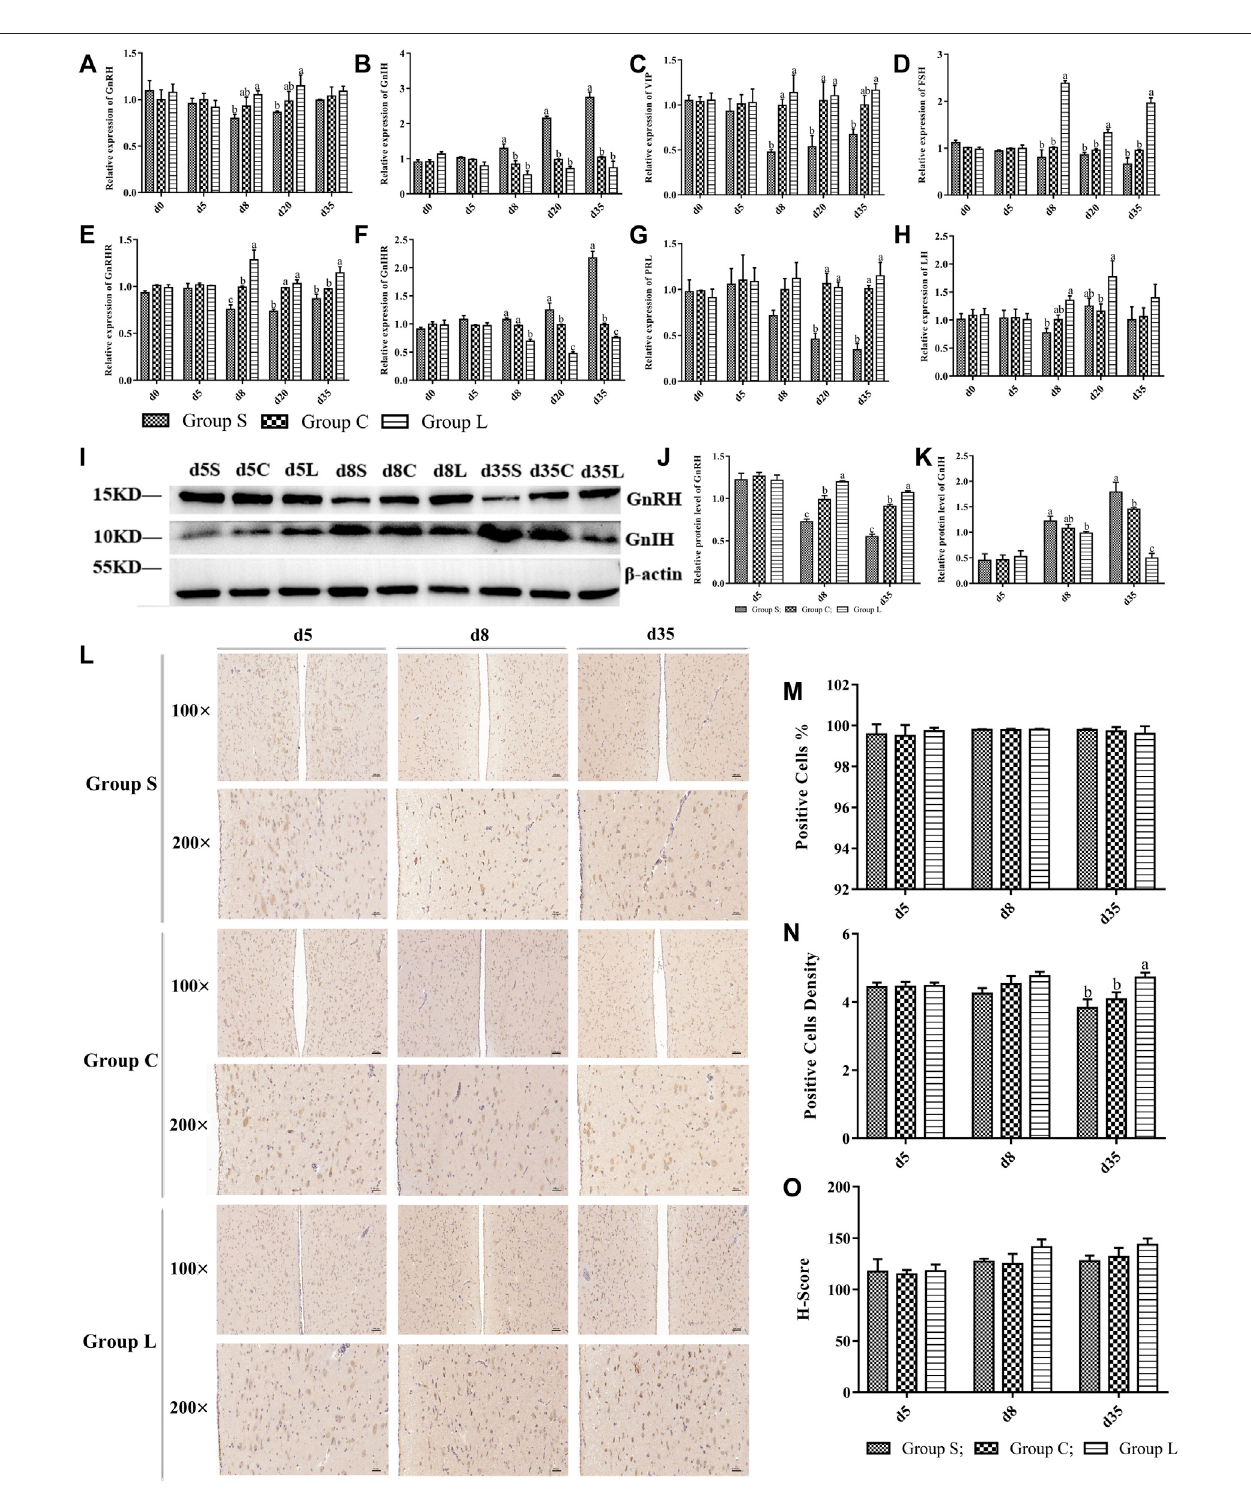
FIGURE 6 | Expression levels of main factors of HPG axis in mountain ducks under different photoperiods. Expression of HPG axis-related genes and proteins. (A – H) indicated the expression levels of the genes of GnRH 、 GnIH 、 VIP 、 FSH 、 GnRHR 、 GnIHR 、 PRL and LH, respectively; (I) , Western Blot results of relative proteinlevelsofGnRHandGnIH; (J) and (K) ,changesintheproteinexpressionofGnRHandGnIH; (L) ,theimmunohistochemicalstainingimagesofGnRH; (M – O) were quantitative analyses of the immunohistochemical results of GnRH, indicating positive cells, positive cells density, and H-Score, respectively.